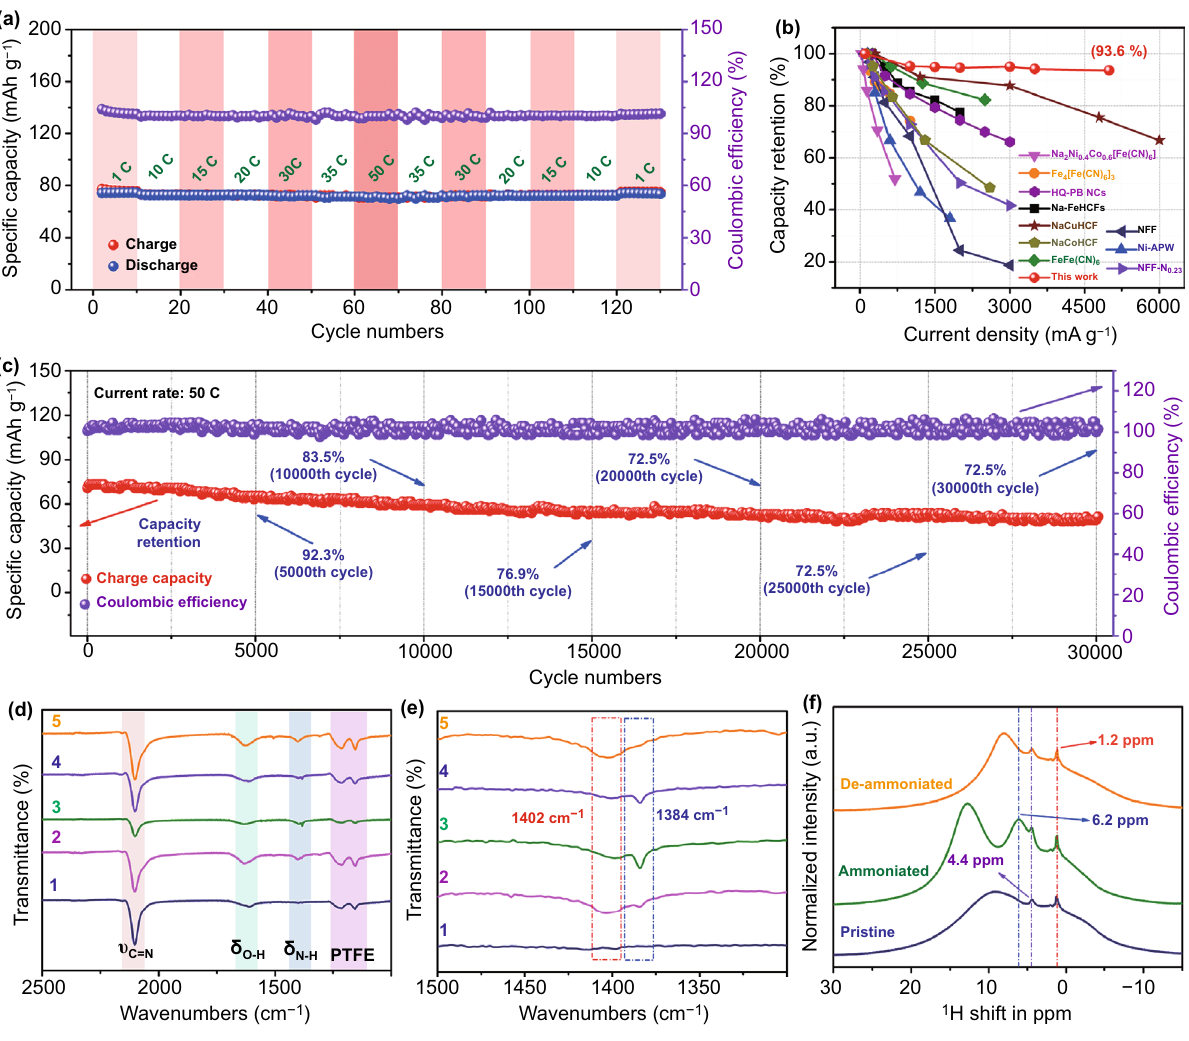
Fig. 4 a Rate performance between 1 and 50 C. b Comparison of rate performance between this work and reported PBAs. c Long-term cycling performance at high current rate of 50 C. d Ex situ FTIR spectra of CuHCF electrode at pristine and ammoniated/de-ammoniated states.